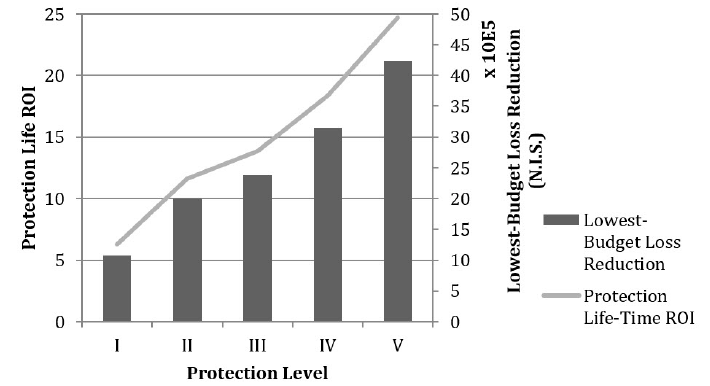
Figure 3. Comparison of ROI between Alternative Protection Levels.